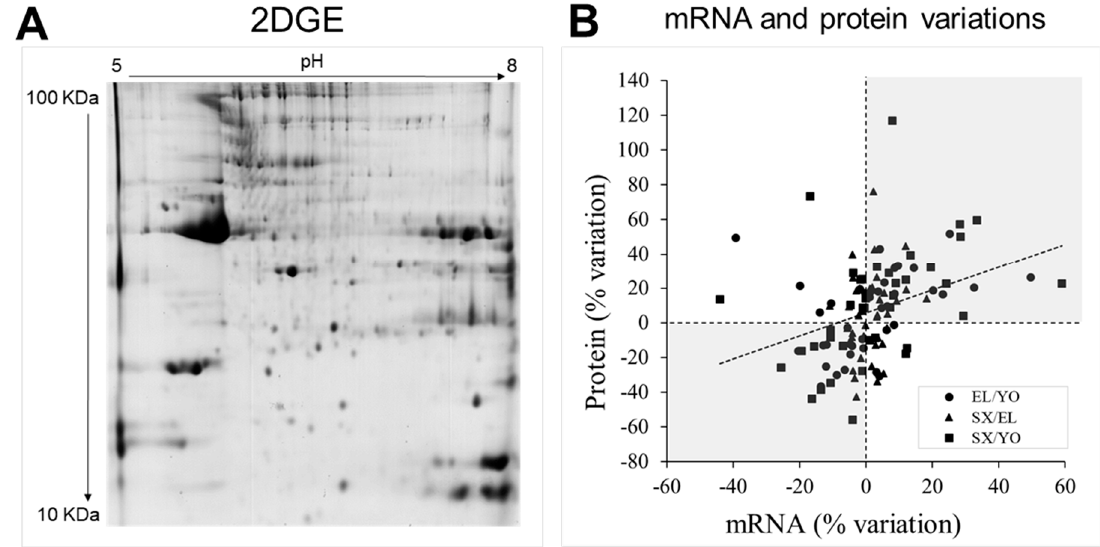
Figure 4. Human muscle proteome. ( A ) Representative 2DGE image obtained from total protein extracts of human vastus lateralis skeletal muscle. 2DGE was performed using a pH range of 5-8. Protein loading was 700 µ g, and gels were stained using colloidal Coomassie blue G-250. Differentially expressed and identified proteins are indicated in Figure S3. ( B ) Comparison of mRNA and protein variations between healthy young men (YO), healthy old men (EL), or old men with metabolic syndrome